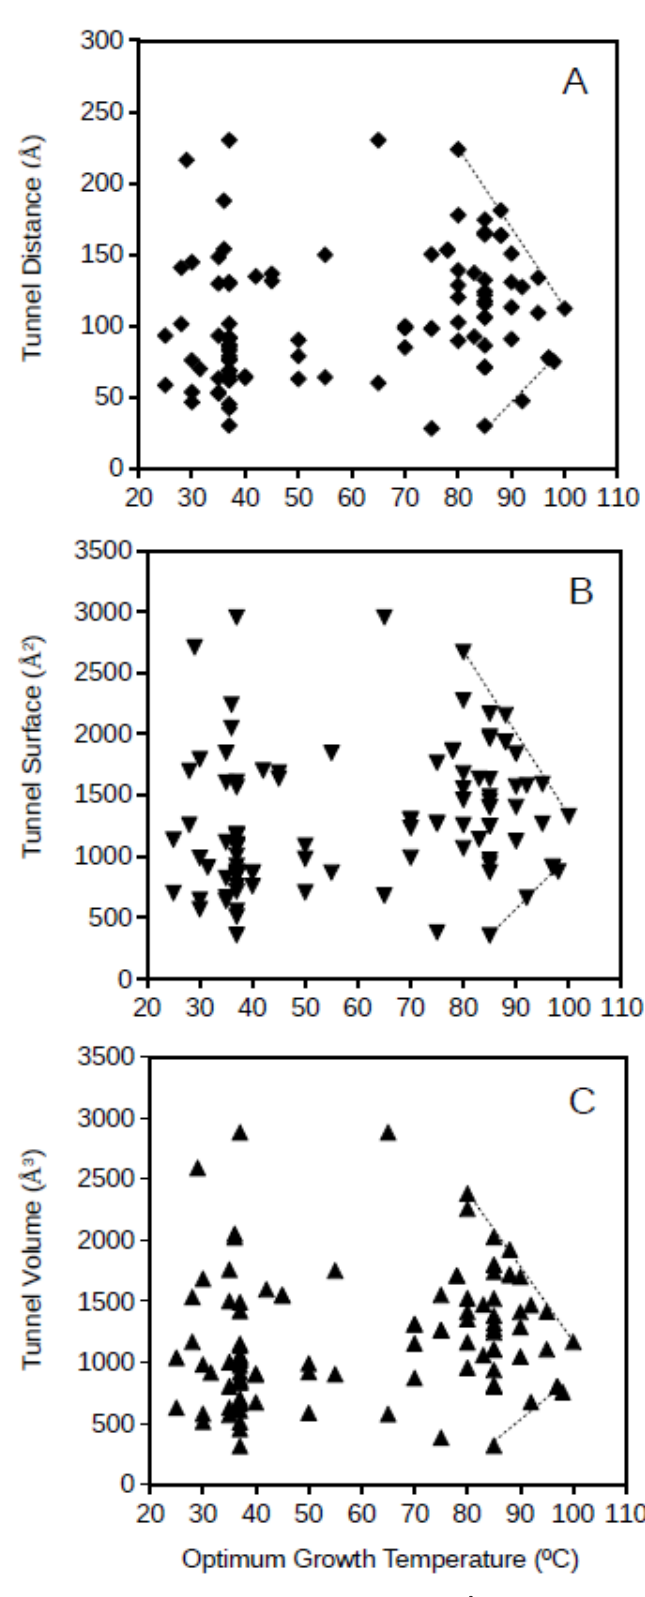
Figure 4. Tunnel distance ( A ), surface ( B ) and volume ( C ) (in Å) dimensions predicted for archaea GPATs ranging in optimum growth temperature from 25 °C to 100 °C. Grey lines represent a visualization of the upper and lower limits for these.